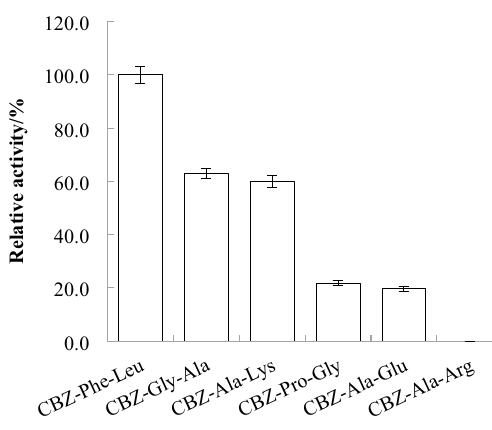
Figure 7. Substrate specificity of recombinant